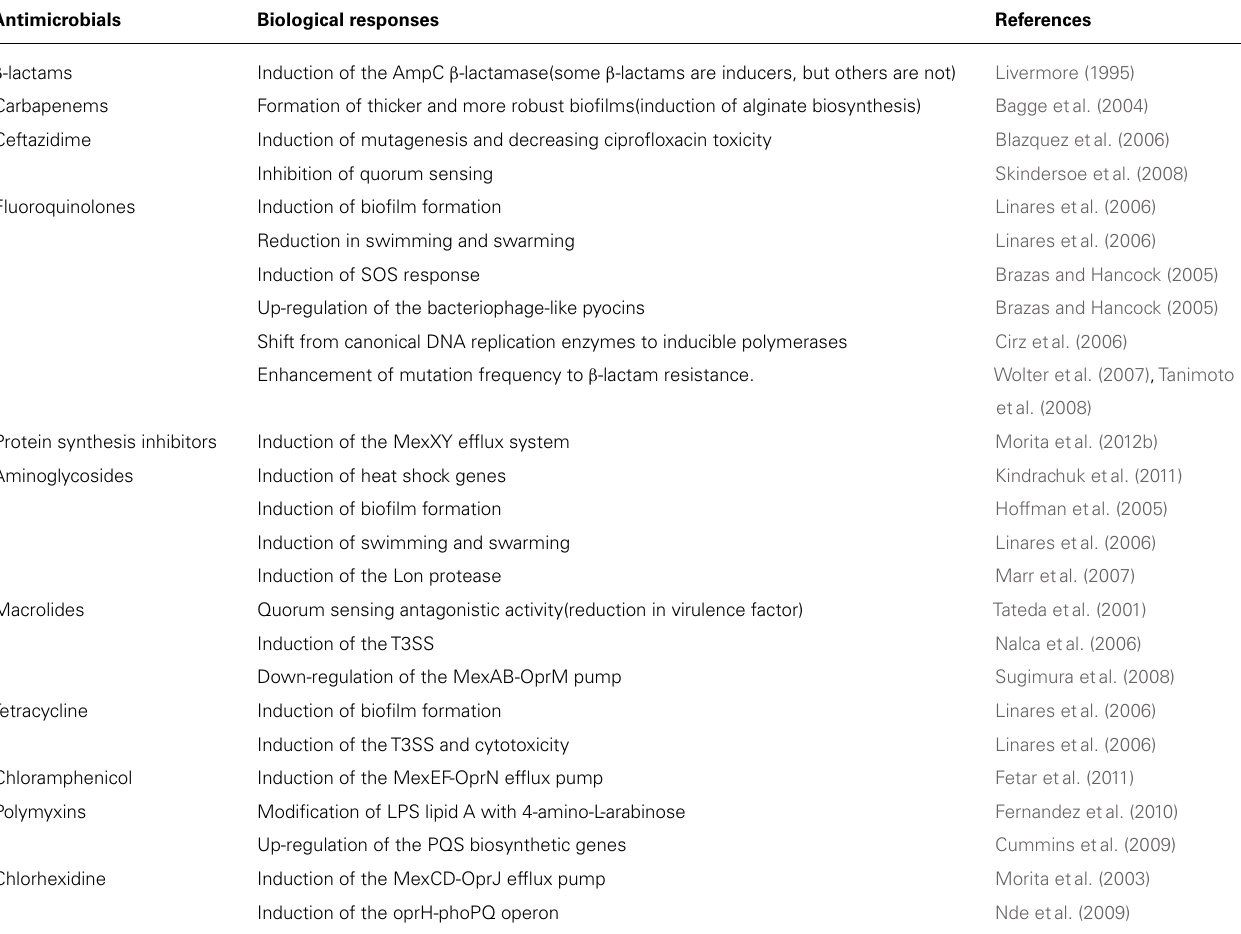
Table 1 | Biological responses of P. aeruginosa exposed to various antimicrobials at levels below the inhibitory concentrations.